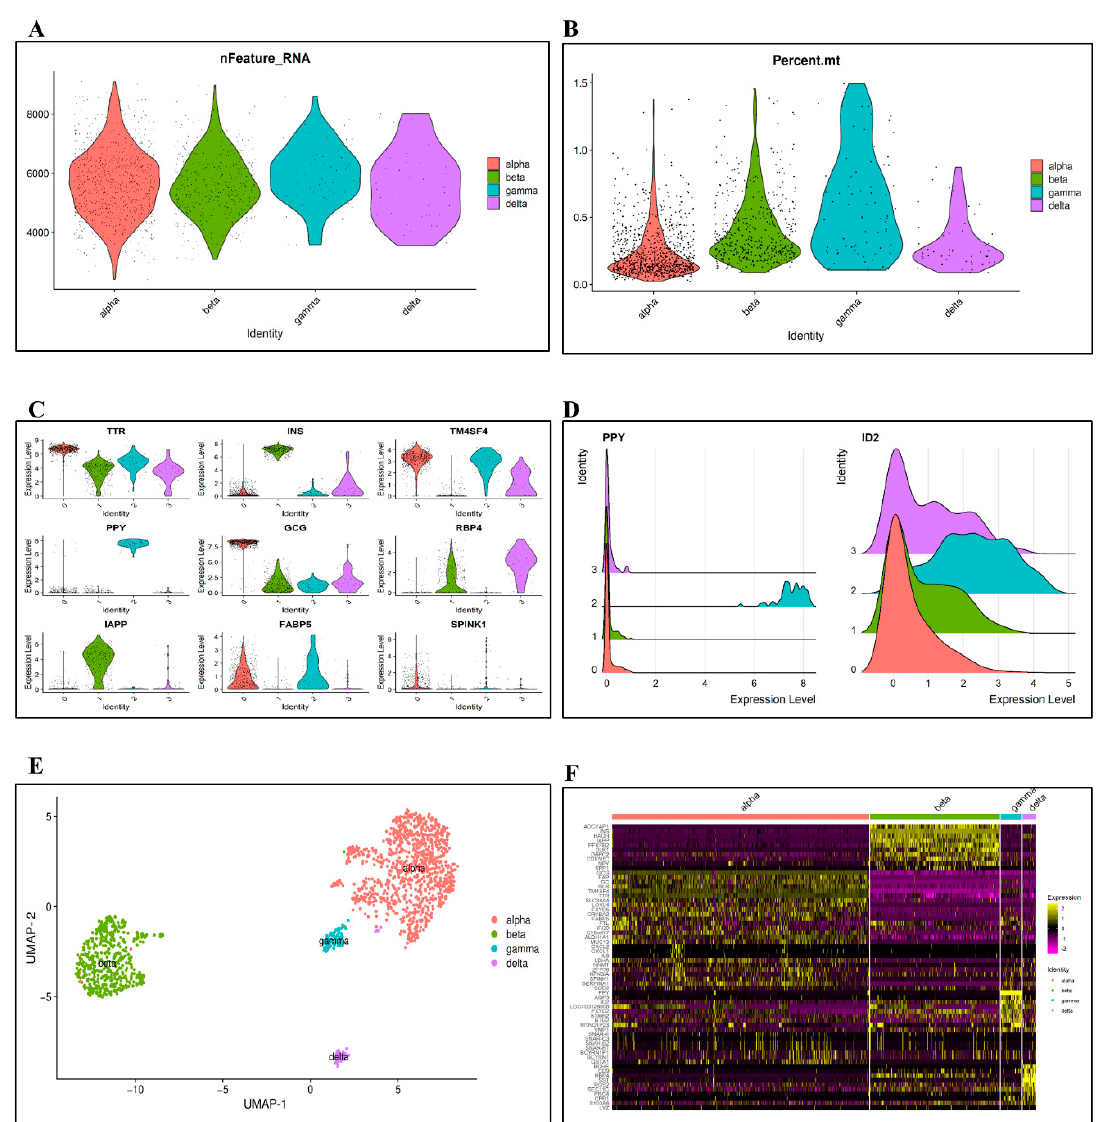
Figure 3. Differential expression analysis in scGENA. ( A ) Gene clustering and distribution in all data cell-types. ( B ) Gene distribution based on the percentage of mitochondria. ( C , D ) Highly differentiated genes. ( E ) Cell-types clustering using UMAP. ( F ) Heatmap showing the level of gene expression in all cell-types.